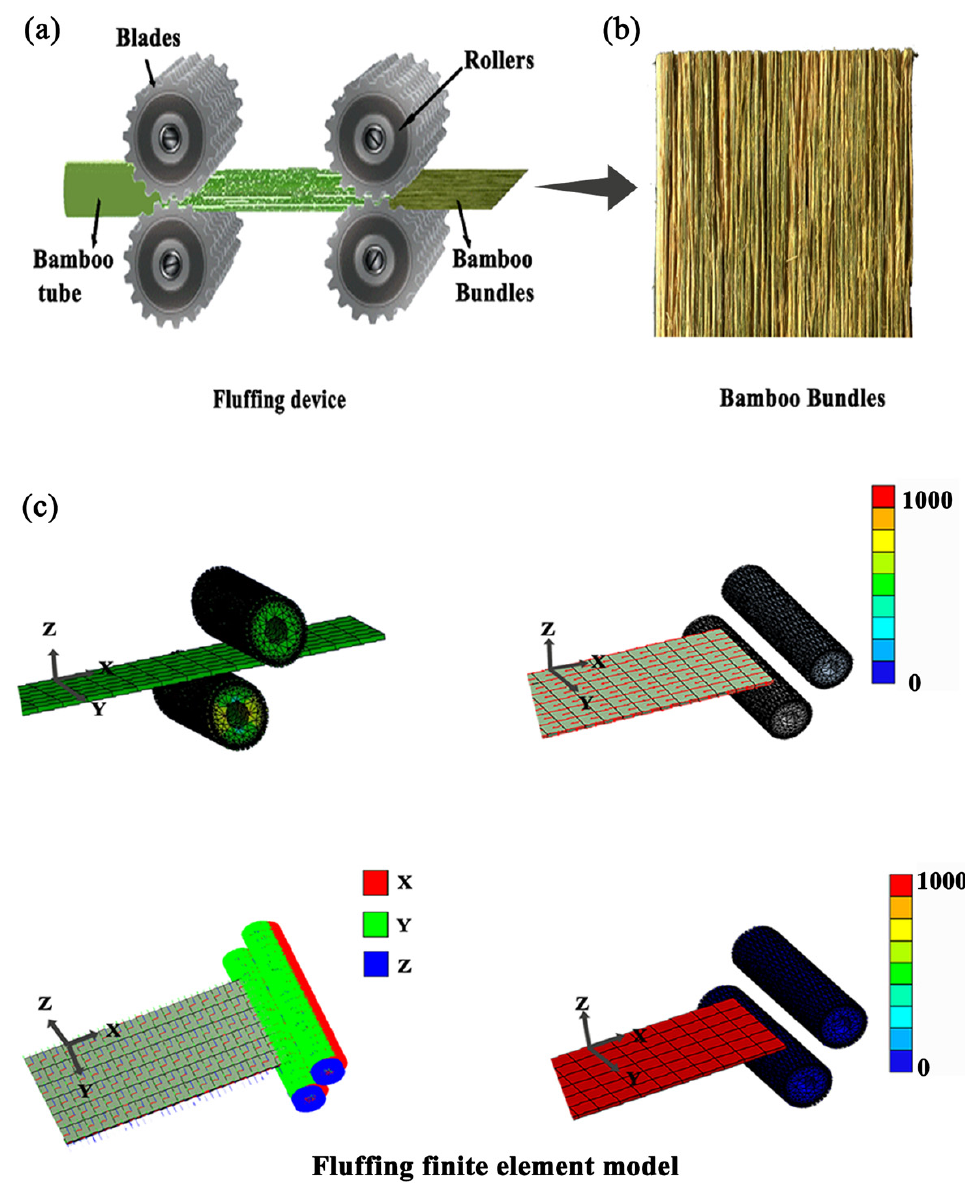
Figure 1. Schematic for fluffing process, product and fluffing finite element model. ( a ) A pair of fluffing rollers with blades; ( b ) bamboo bundles image; ( c ) fluffing finite element model.